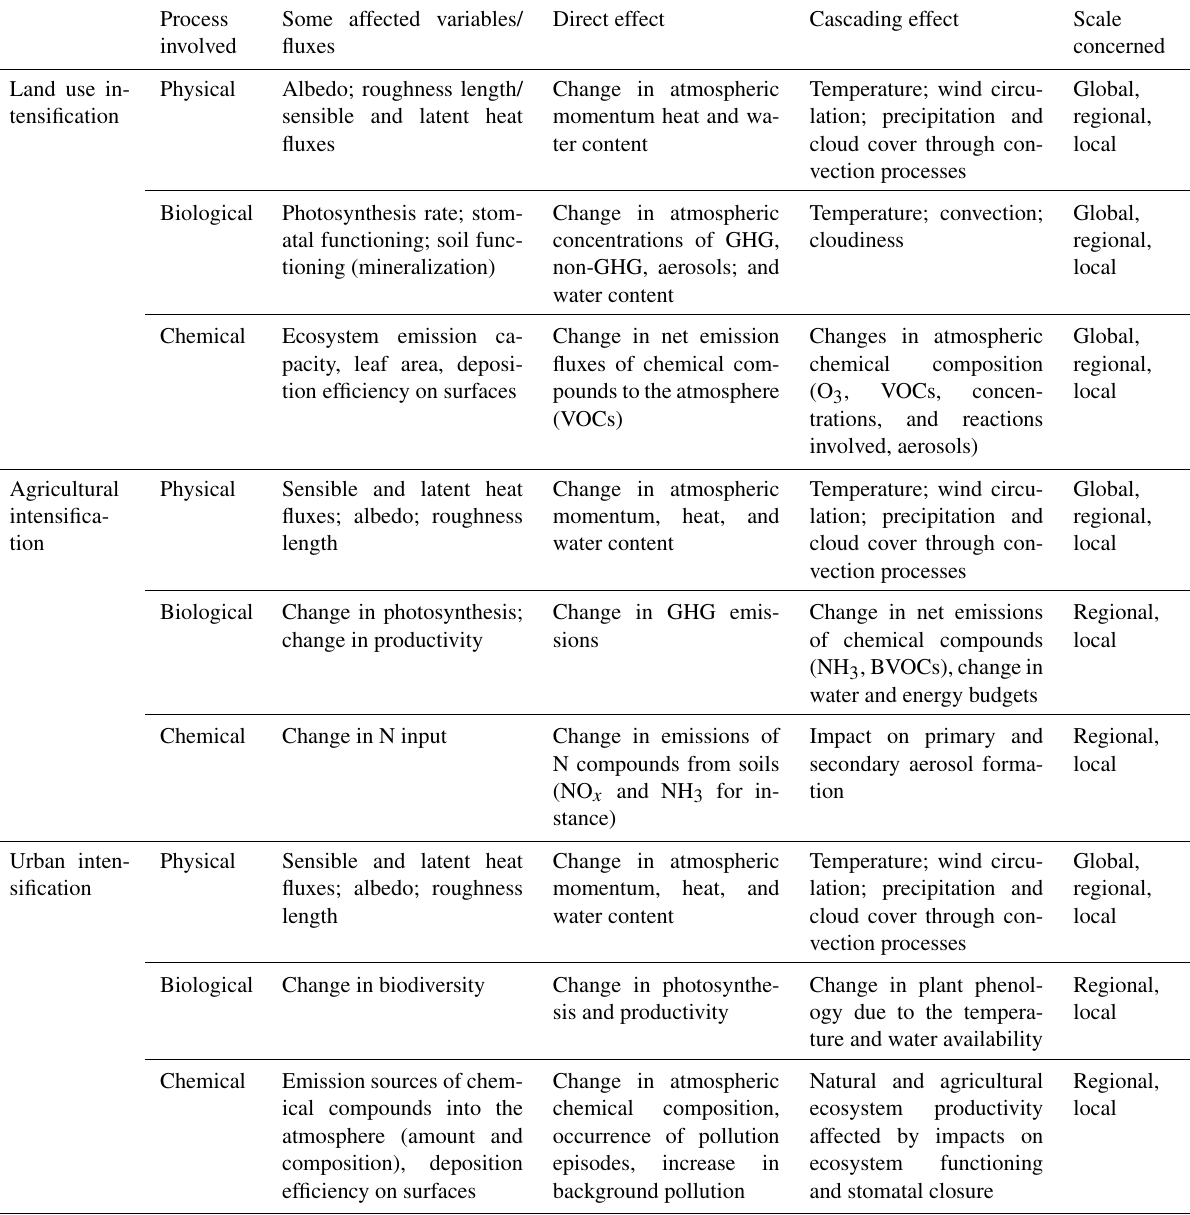
Table 2. Synthesis of direct and indirect effects of land use and land cover changes as well as land management changes as seen from a physical, biological, or chemical